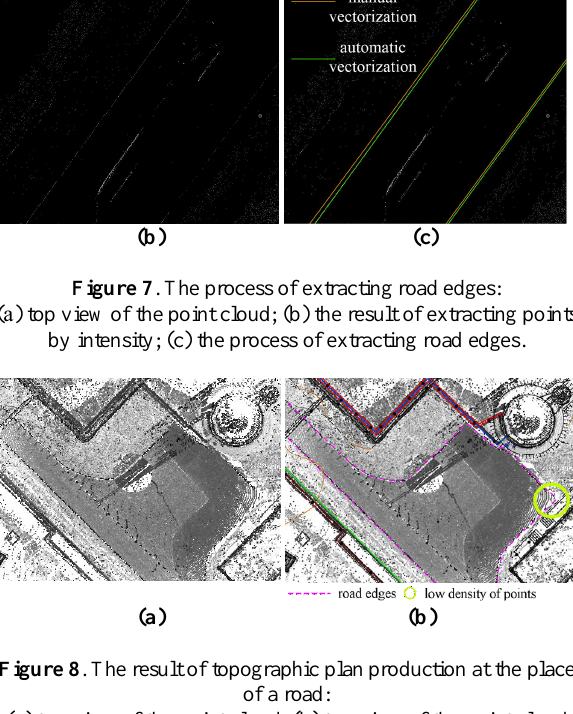
Figure 5 . Creating horizontal sections for building extraction: